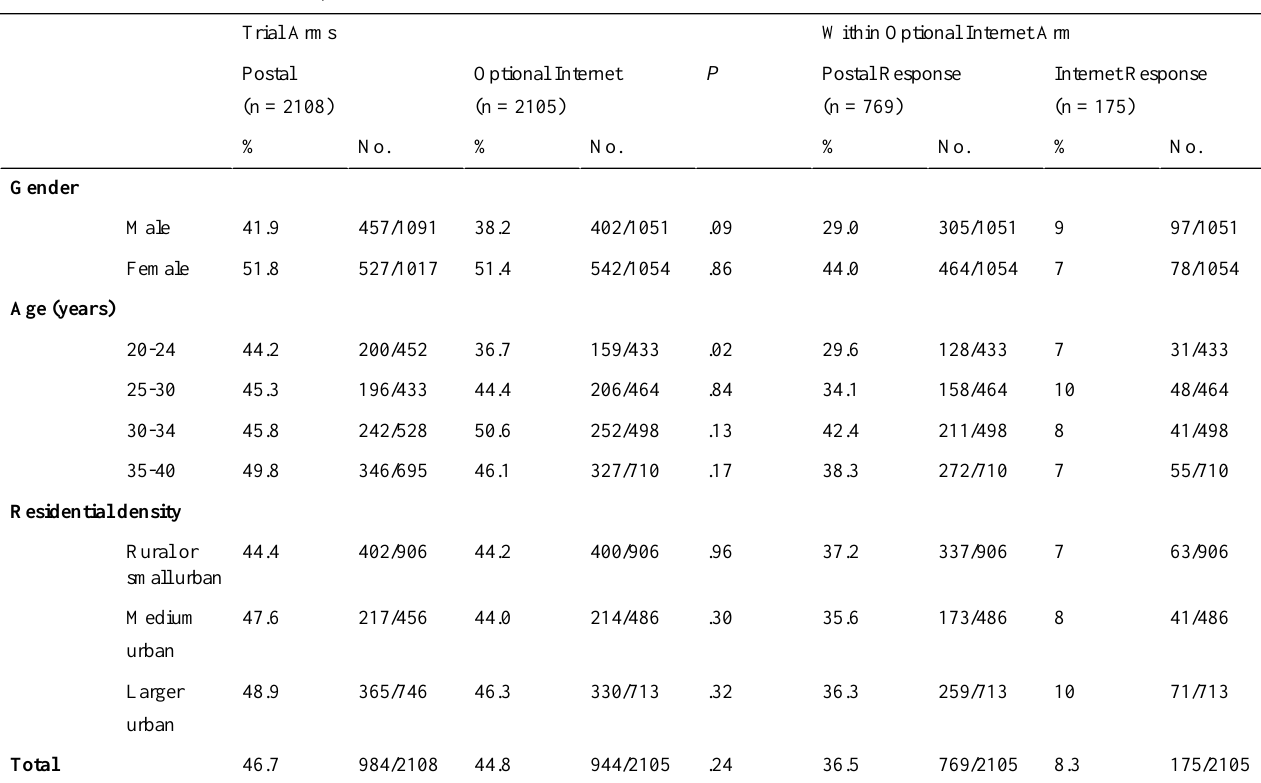
Table 2. Effect of intervention on response